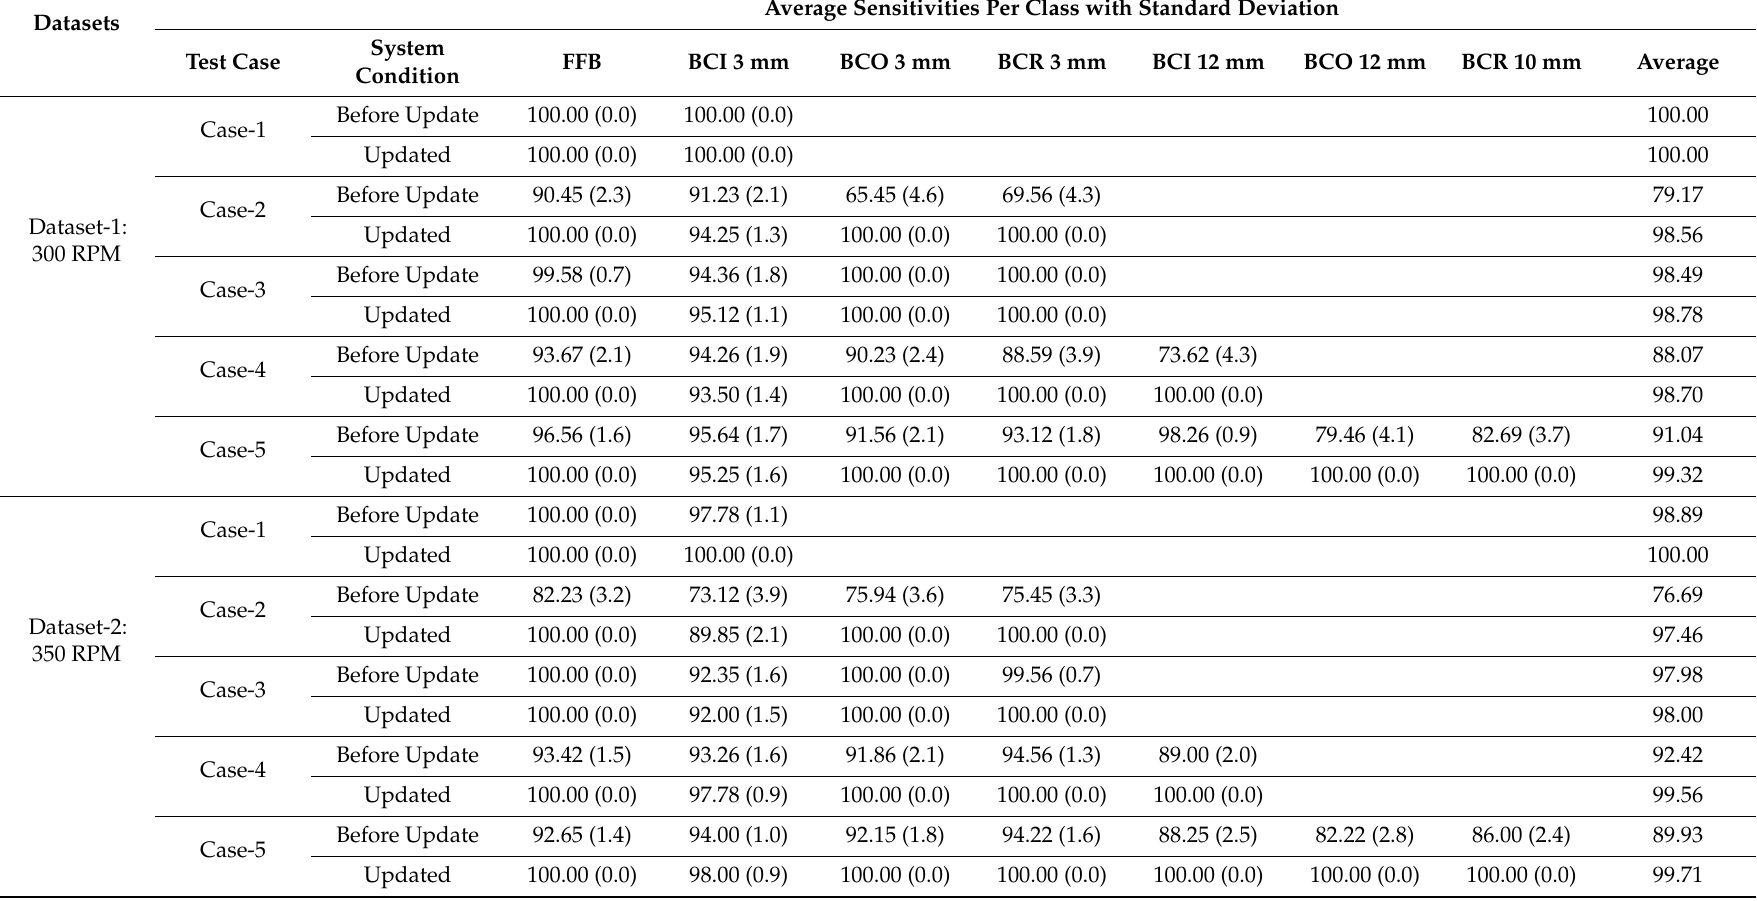
Table 4. Diagnosis performance of five successive test cases of datasets 1 to 5 in terms of average sensitivity per class.